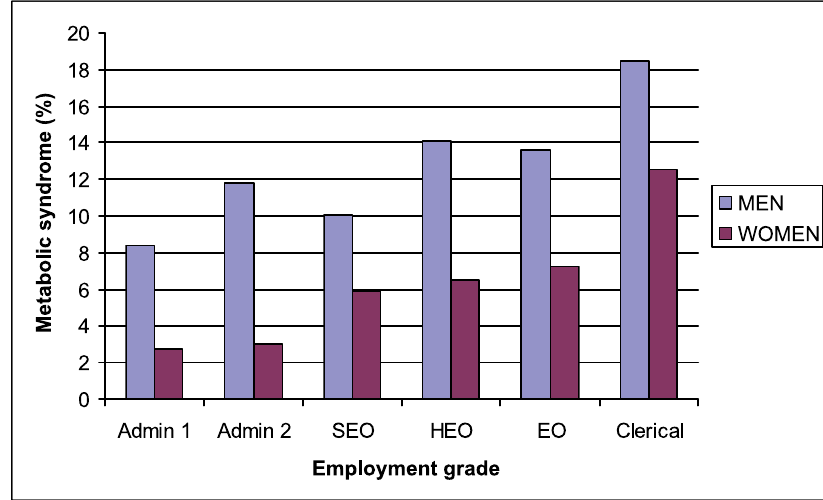
Figure 1. Prevalence of Metabolic Syndrome (Adult Treatment Panel III Definition) by Civil Service Employment Grade in the Whitehall II Study 5,382 men and 2,389 women aged 39–63. Trend test from logistic model adjusted for age and ethnicity. Admin 1, highest level administrators, e.g., permanent secretary; SEO, senior